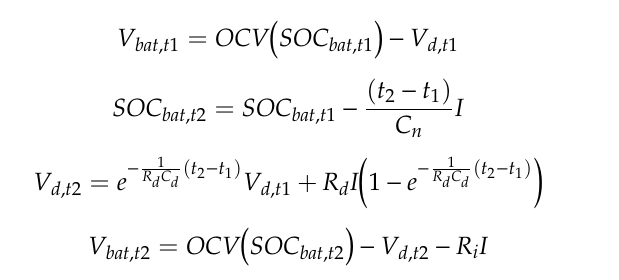
Figure 3. Electrical equivalent circuit model of lithium